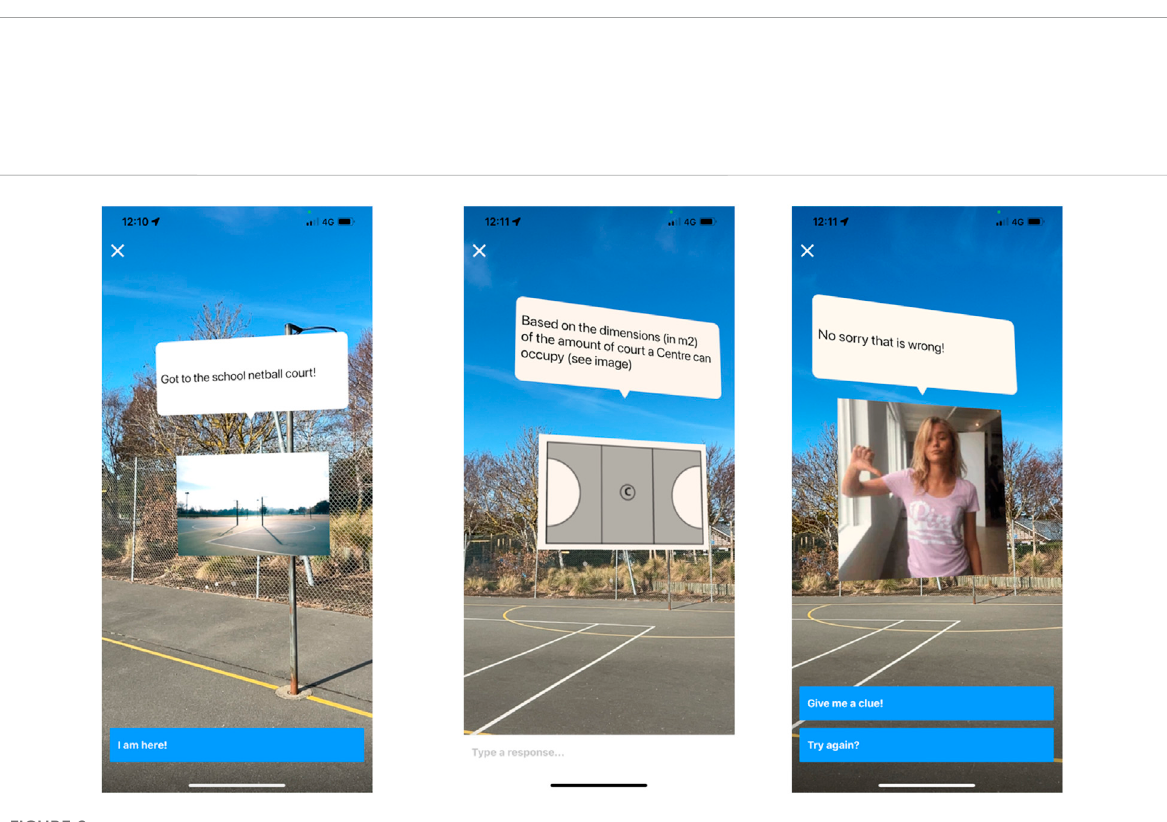
Frontiers in Virtual